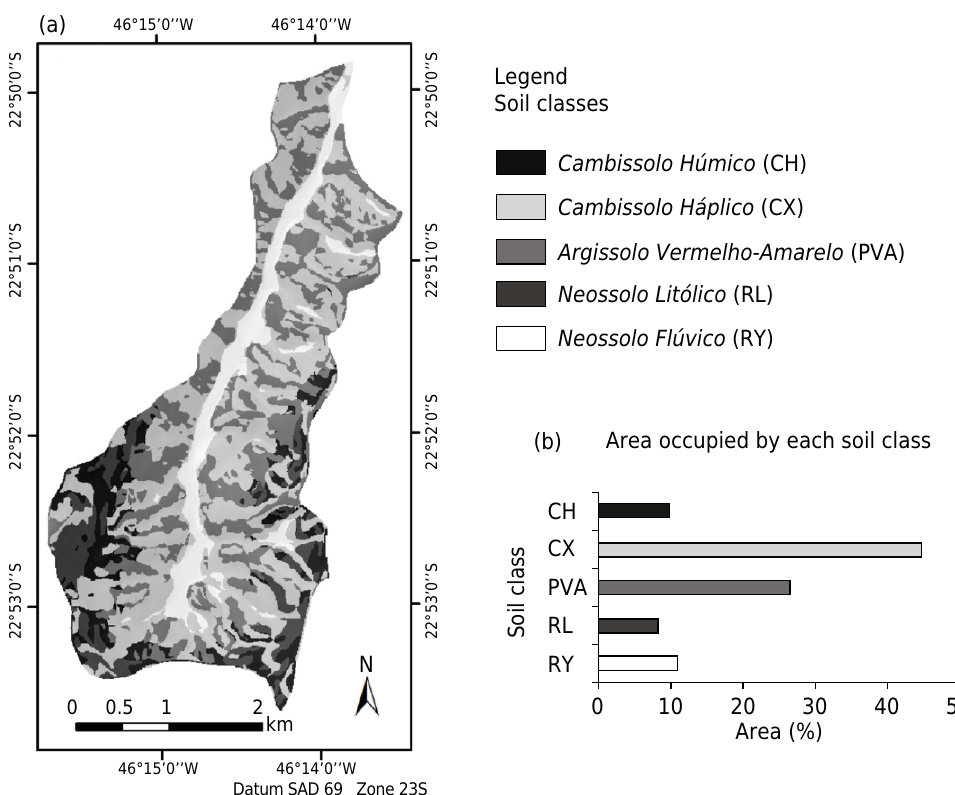
Figure 4. Soil class map (a) and percentage of the area occupied by each soil class (b) in the Posses watershed, Extrema, MG. Soil classes according to Soil Taxonomy (USDA, 2014): Cambissolo Húmico (Inceptisol), Cambissolo Háplico (Ochrept), Argissolo Vermelho-Amarelo (Red-Yellow Ultisol), Neossolo Litólico (Udorthent) and Neossolo Flúvico (Fluvent).